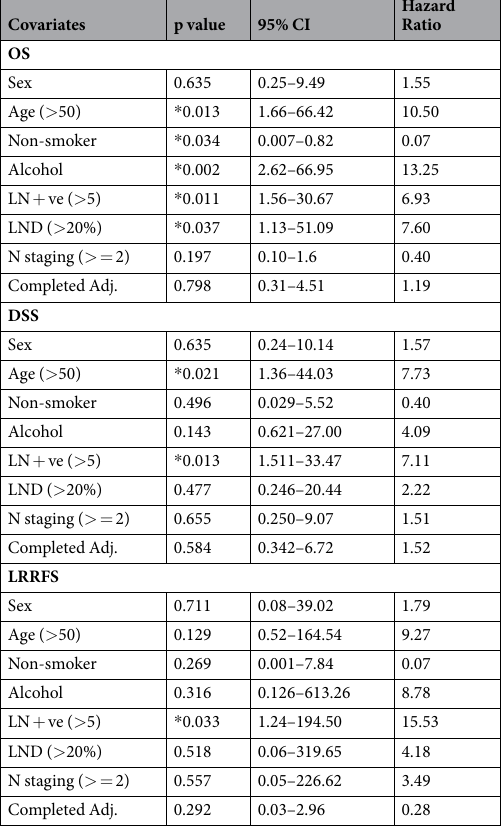
istics and lymph node analyses, with a summary of results in Table 4. Total lymph node number was excluded due to having no association with survival in the univariate analysis. Results showed that patients with a number